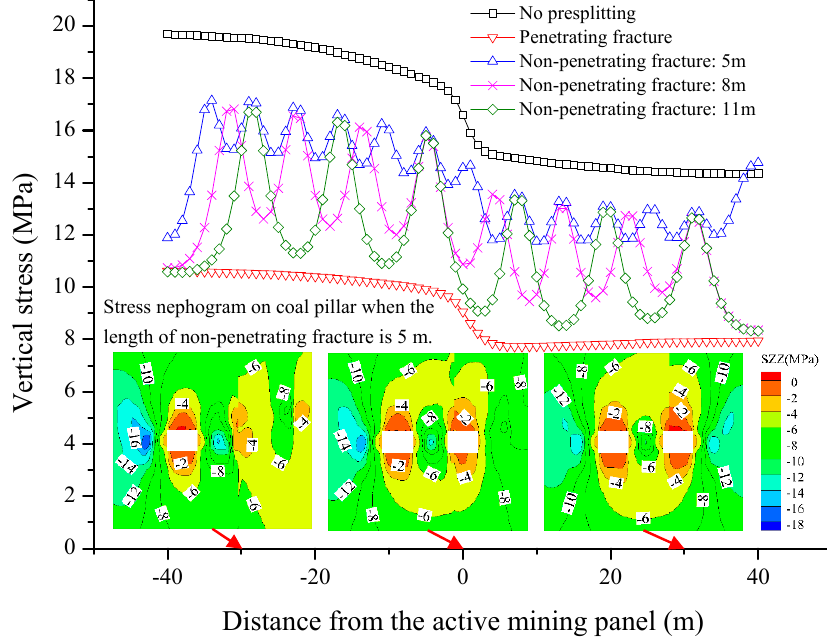
Figure 14. Stress distribution characteristics of the coal pillar center.